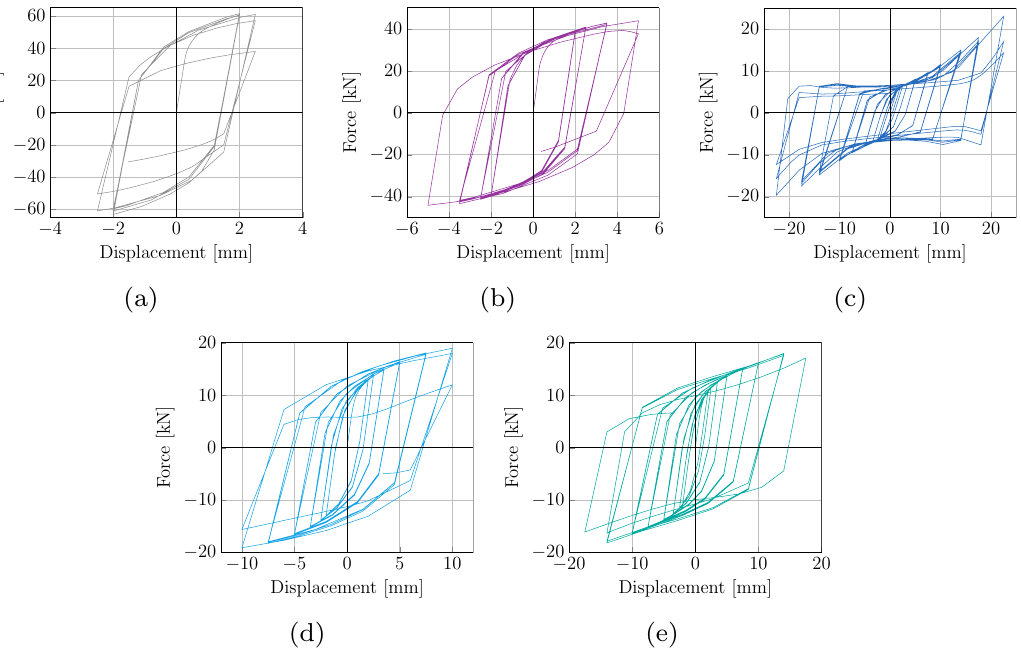
Figure 5. Hysteresis curves of SPSYDs ( a ) P1, ( b ) P2, ( c ) P3, ( d ) P4 and ( e )